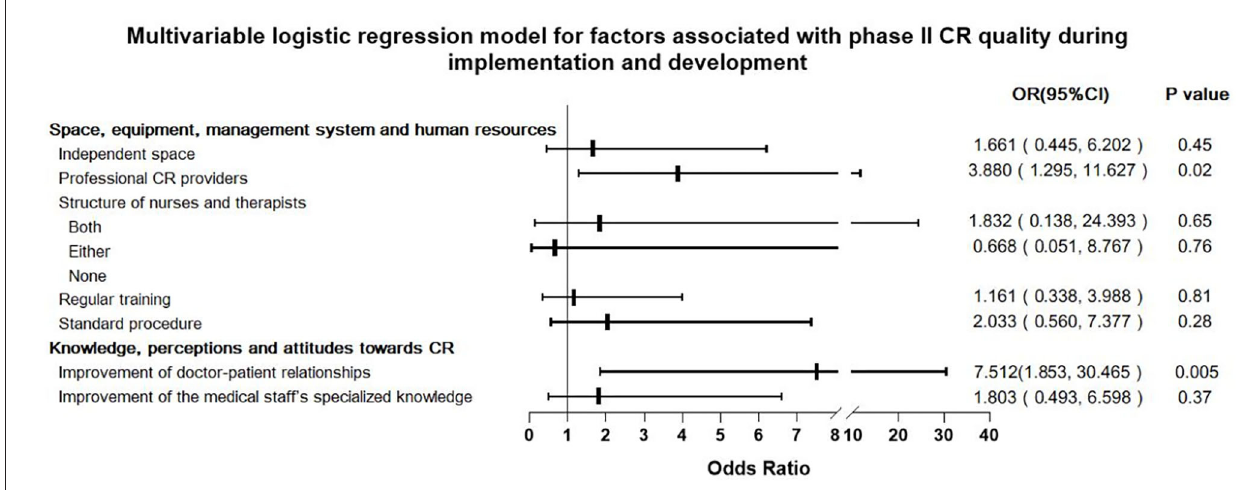
FIGURE 5 | Multivariable logistic regression model for factors associated with phase II cardiac rehabilitation (CR) quality during implementation and